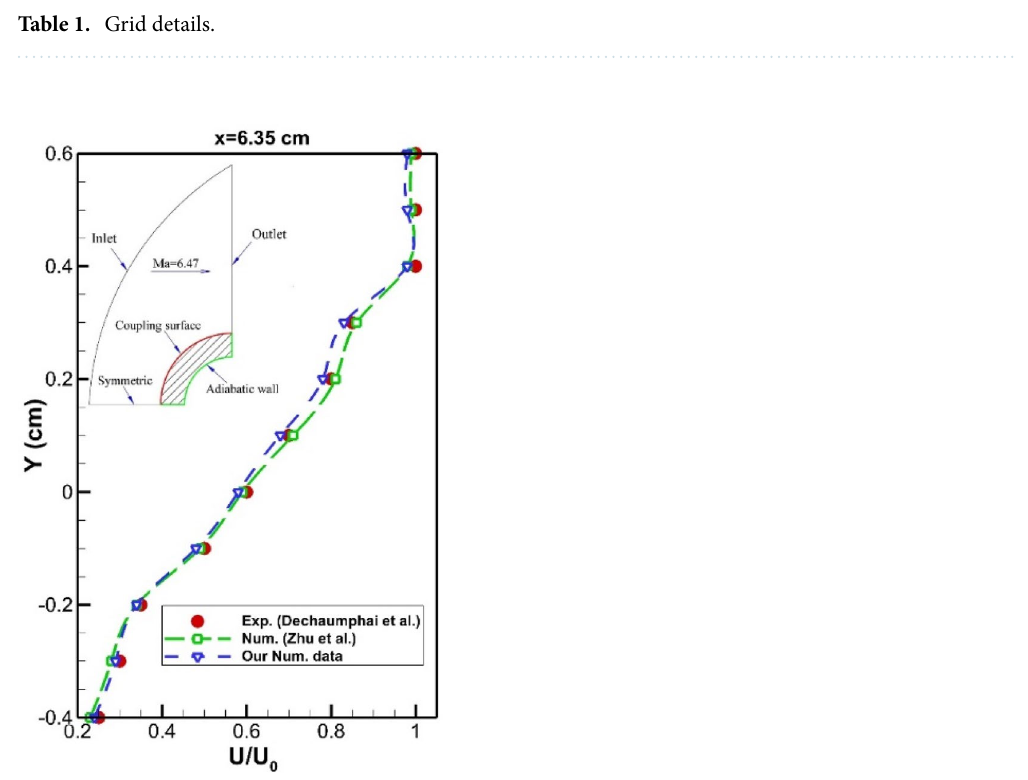
Figure 3. Validation of velocity profile 45